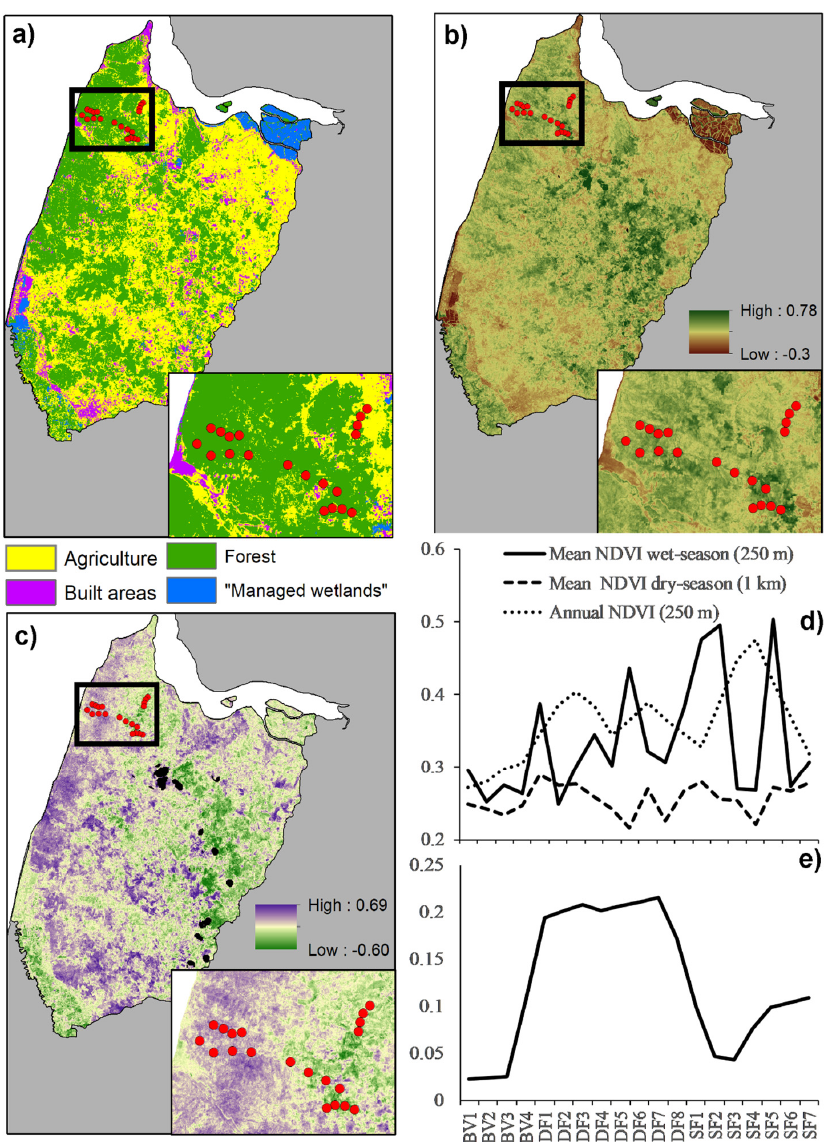
Figure 2. Landscape characteristics of the study landscape. ( a ) Land-cover map; ( b ) Mean Annual NDVI; ( c ) Seasonality: Wet season NDVI—Dry season NDVI. Areas with high values indicate high seasonality; ( d ) NDVI metrics used as predictors in occupancy models; ( e ) Seasonality across sampling areas. Boxes detail wildlife sampling area. Red dots indicate sampling sites.